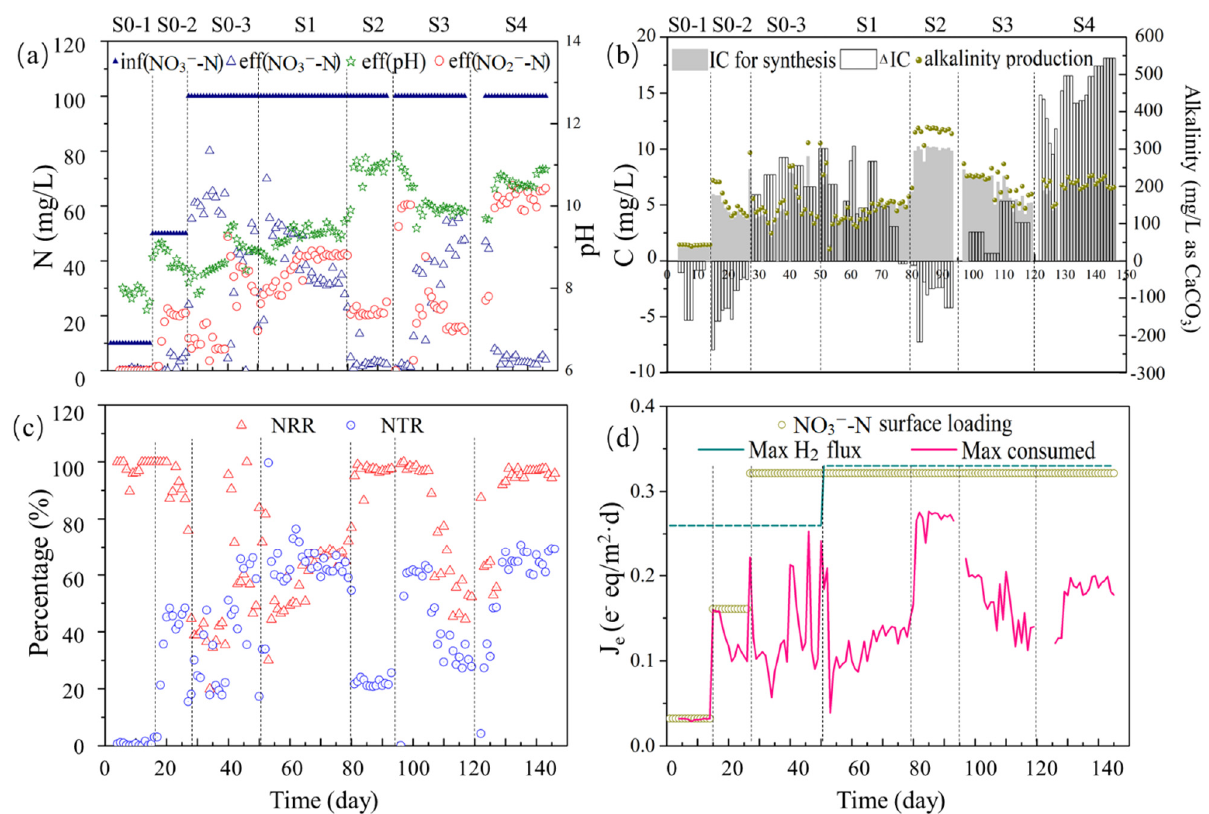
Figure 2. Performance of the MBfR for treatment stages S0-1, S0-2, S0-3, S1, S2, S3, and S4: ( a ) Concentrations of influent NO 3 − -N and effluent NO 3 − -N and NO 2 − -N, along with pH; ( b ) Concentration of IC used for synthesis and changes in IC and alkalinity. Δ IC is defined as (Inf.IC − Eff.IC); ( c ) NRR (nitrate removal ratio), defined as (Inf.NO 3 − − Eff.NO 3 − )/Inf.NO 3 − ; and NTR (nitrate transformation ratio), defined as Eff.NO 2 − /(Inf.NO 3 − − Eff.NO 3 − ); ( d ) calculated maximum H 2 flux, NO 3 − -N surface loading, and maximum NO 3 − -reduction consumption flux (all in e − eq/m 2 -d).